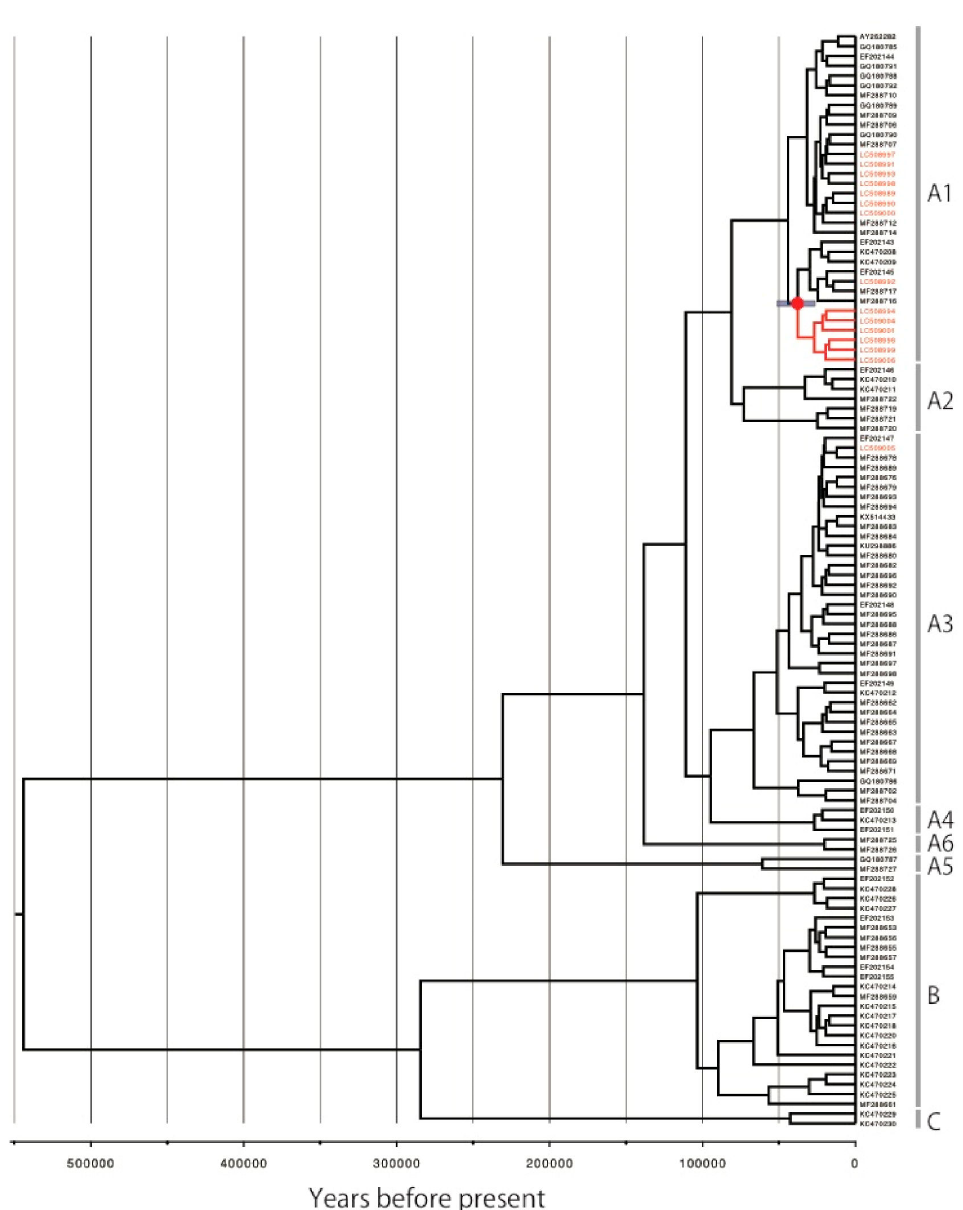
Figure 5. Bayesian MCMC phylogenetic tree of HPV18. The concatenated E6 , E7 , E1 , E2 , L2 and L1 sequences from 112 HPV18 genomes were analyzed in BEAST2. Time-scaled maximum-clade credibility tree is shown. Red node indicates the position of the most recent common ancestor for the Japan-specific HPV18 variants. Blue bar indicates 95% highest posterior density